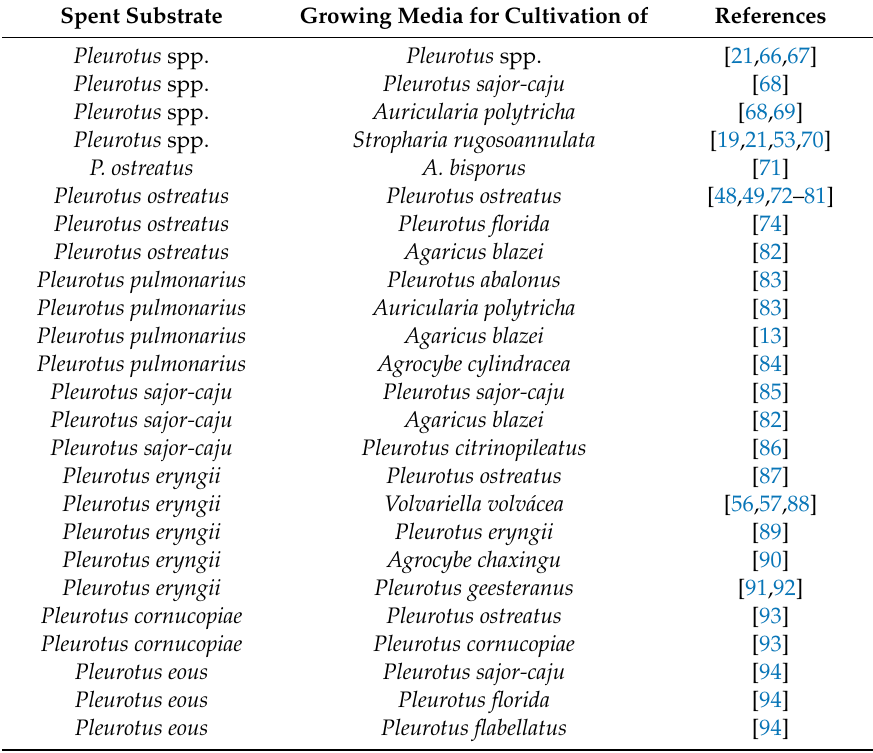
Table 2. Reuse of SMS of Pleurotus spp. in new substrate